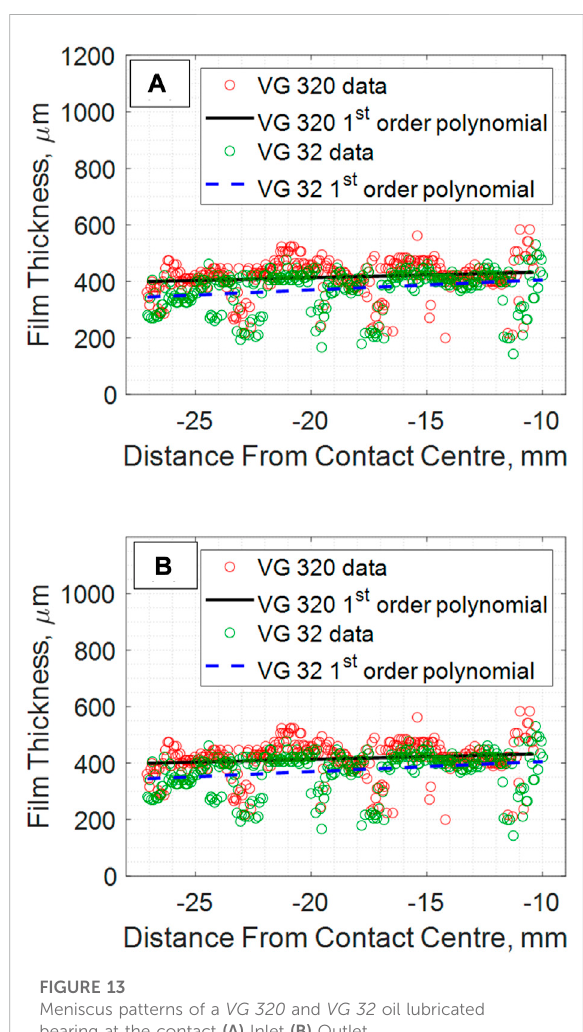
FIGURE 13 Meniscus patterns of a VG 320 and VG 32 oil lubricated bearing at the contact (A) Inlet (B)